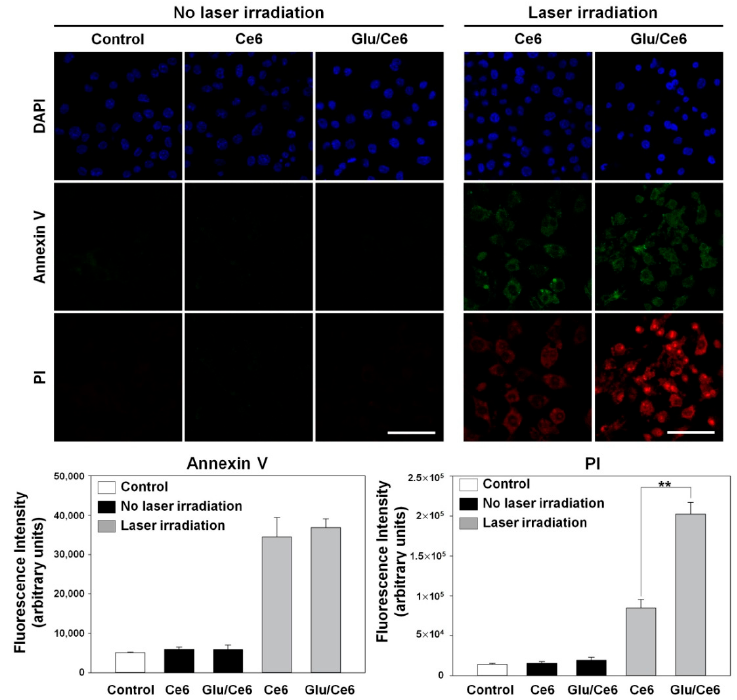
Figure 7. In vitro phototoxic effects of Ce6 and Glu/Ce6 on foam cells before and after laser irradiation (670 nm, 1 min irradiation at 50 mW/cm 2 ). ( a ) Annexin V and propidium iodide (PI) stainings were done to evaluate PDT effects of Ce6 and Glu/Ce6 on foam cells. Scale bar: 30 µ m. Quantitative fluorescence intensity (FI) of ( b ) annexin V (AV) and ( c ) propidium iodide (PI) for each experimental group. ** p <